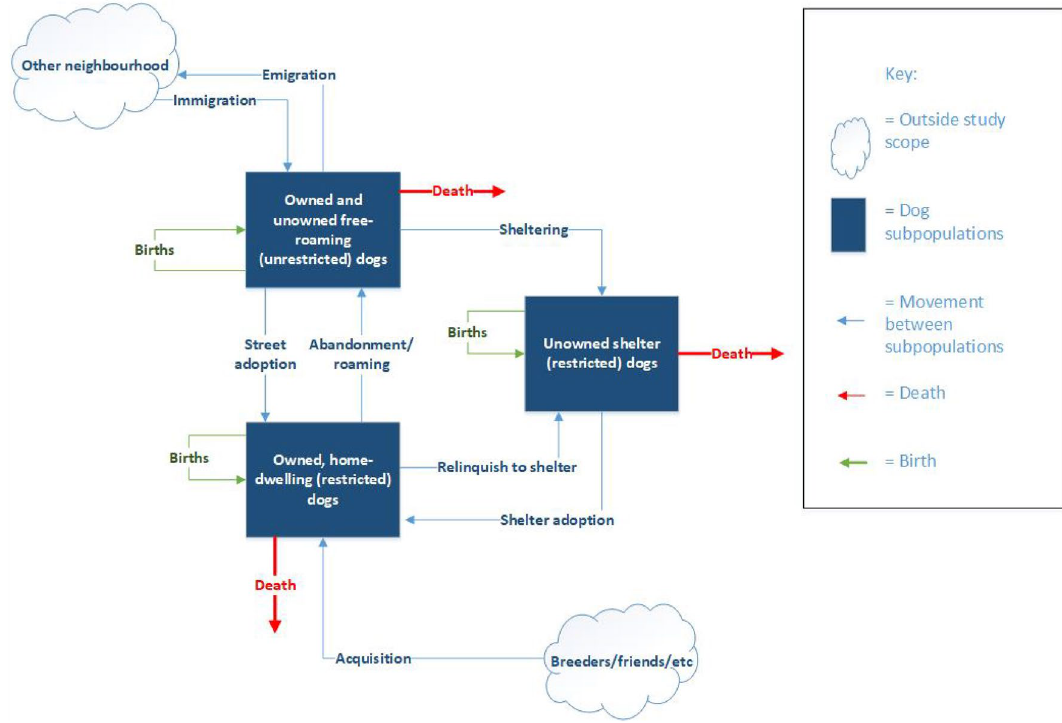
Figure 1. Process of dog subpopulation increase/decrease, with dog population divided into free-roaming dogs (including both owned and unowned free-roaming dogs), unowned shelter dogs, and owned (restricted) dogs, as well as the movement of dogs between these different dog